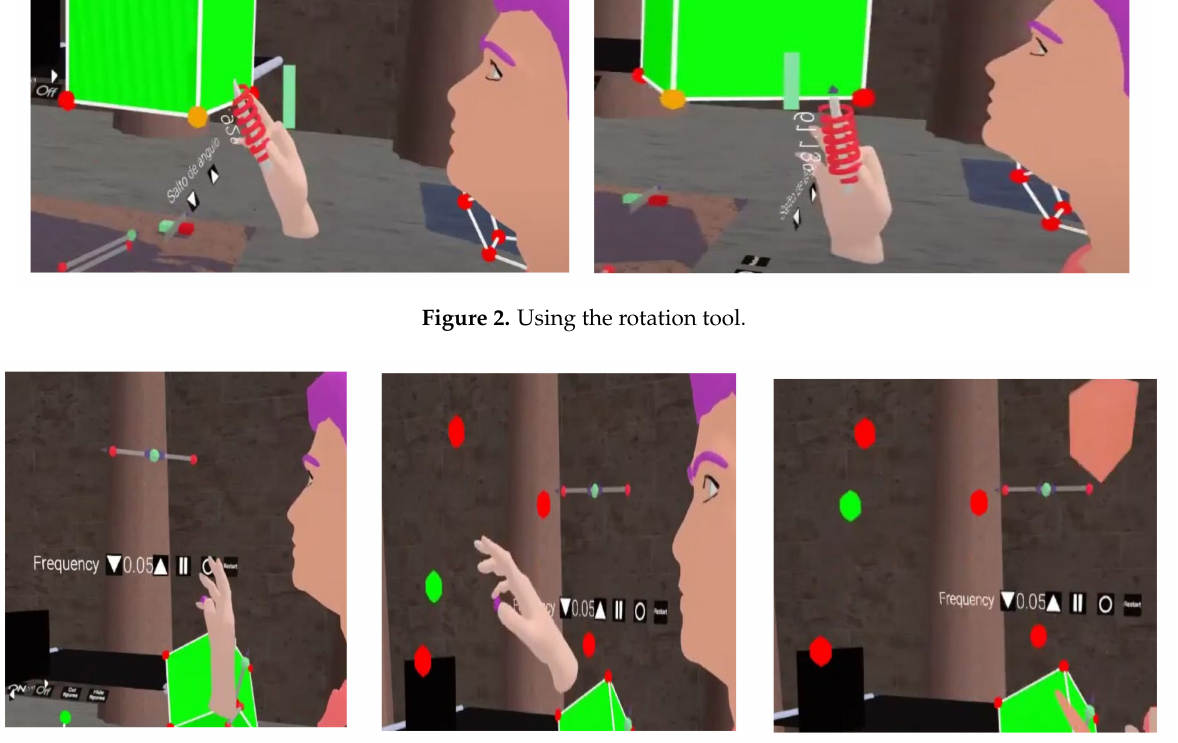
Figure 3. Using the slider tool between